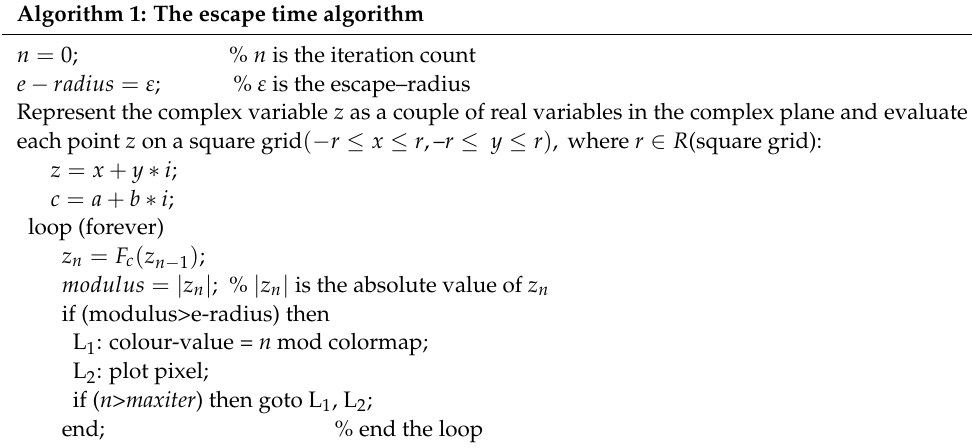
Algorithm 1: The escape time